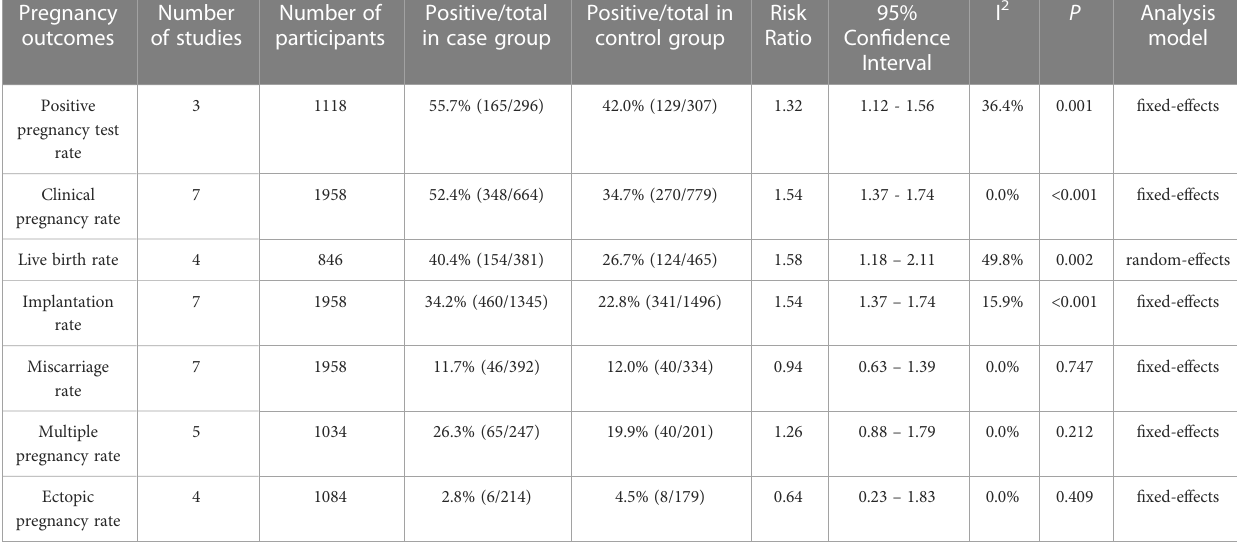
TABLE 4 Meta-analysis of all studies comparing pregnancy outcomes between case and control groups in patients with